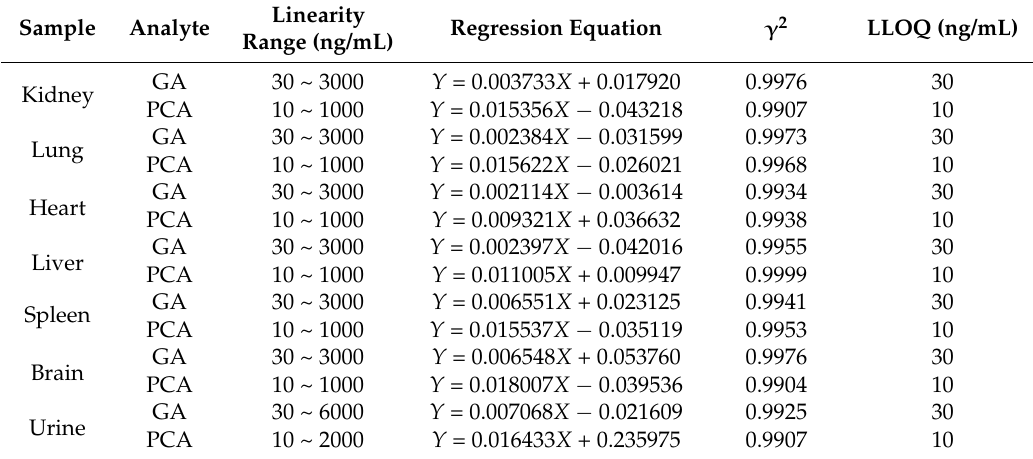
Table 1. Regression equation, linear range, and LLOQ of GA and PCA in rat tissue and urine